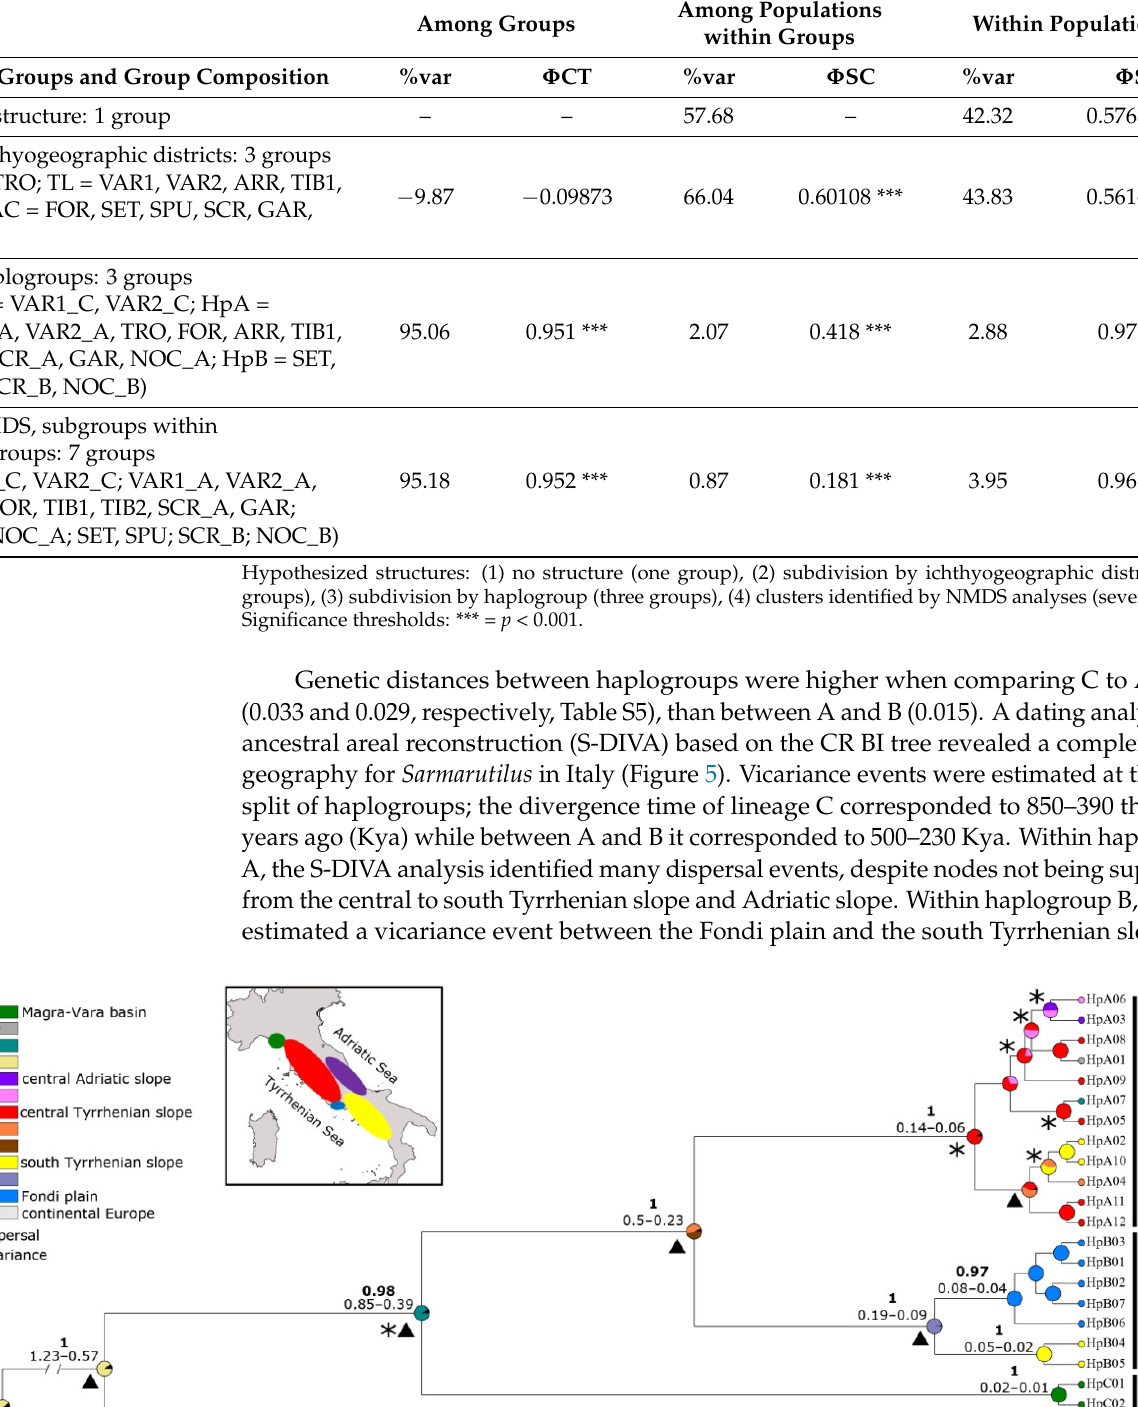
Table 3. AMOVA hierarchical analysis for Italian specimens, examining the partitioning of genetic variance of the mitochondrial control region (CR).